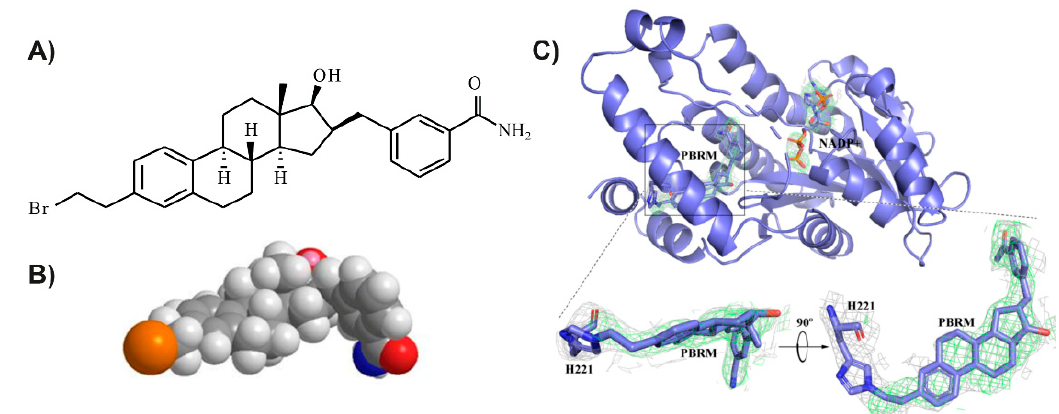
Figure 2. The irreversible steroidal 17 β -HSD1 inhibitor PBRM: ( A ) two-dimensional (2D) representation; ( B ) three-dimensional (3D) representation; and ( C ) PBRM linked covalently to 17 β -HSD1 [45].